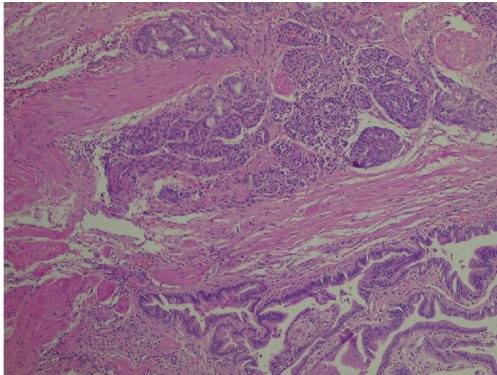
Figure 1: H & E stain 40x: presence of pancreatic tissue (few ducts and large number of acini with absence of islets), i.e., type II, around the cystic